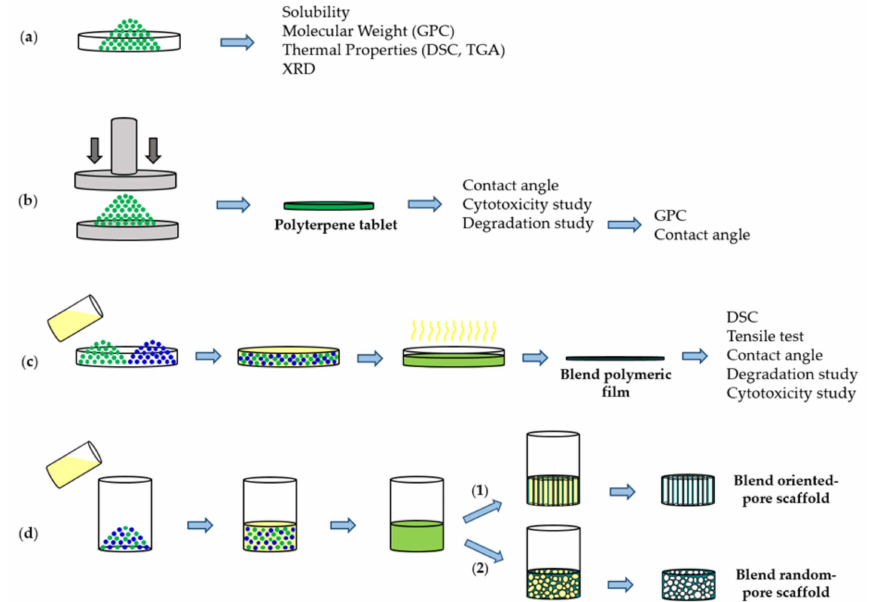
Figure 2. Graphical scheme of study design. Green biobased terpene derivative polymer